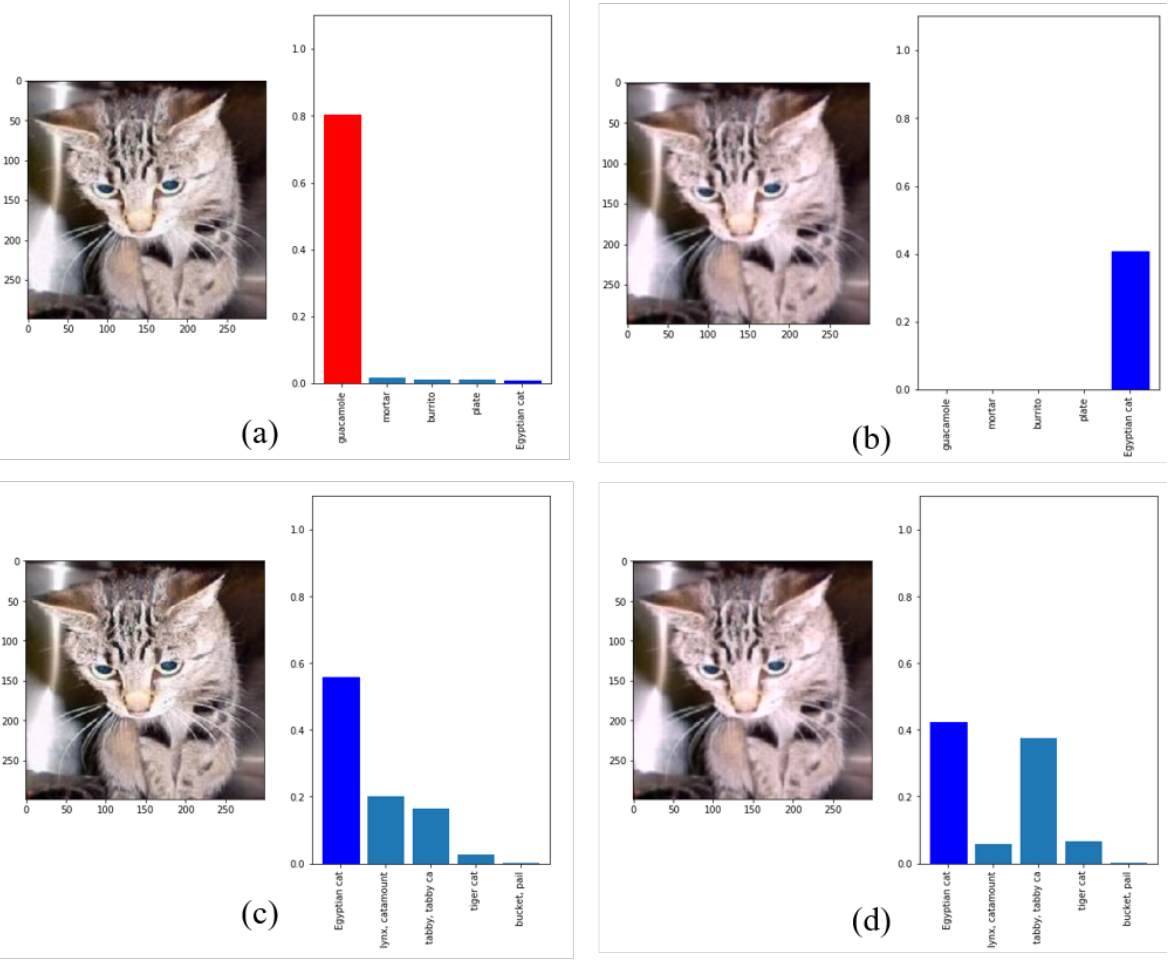
Figure 6. Showing the accuracy values for ( a ) the top five classes in the adversarial image. ( b ) the same five classes as in ( a ) for the output of the DIP with ( a ) as the input. ( c ) the top five classes in the normal image. ( d ) the same five classes as in ( c ) for the output of the DIP with ( c ) as the